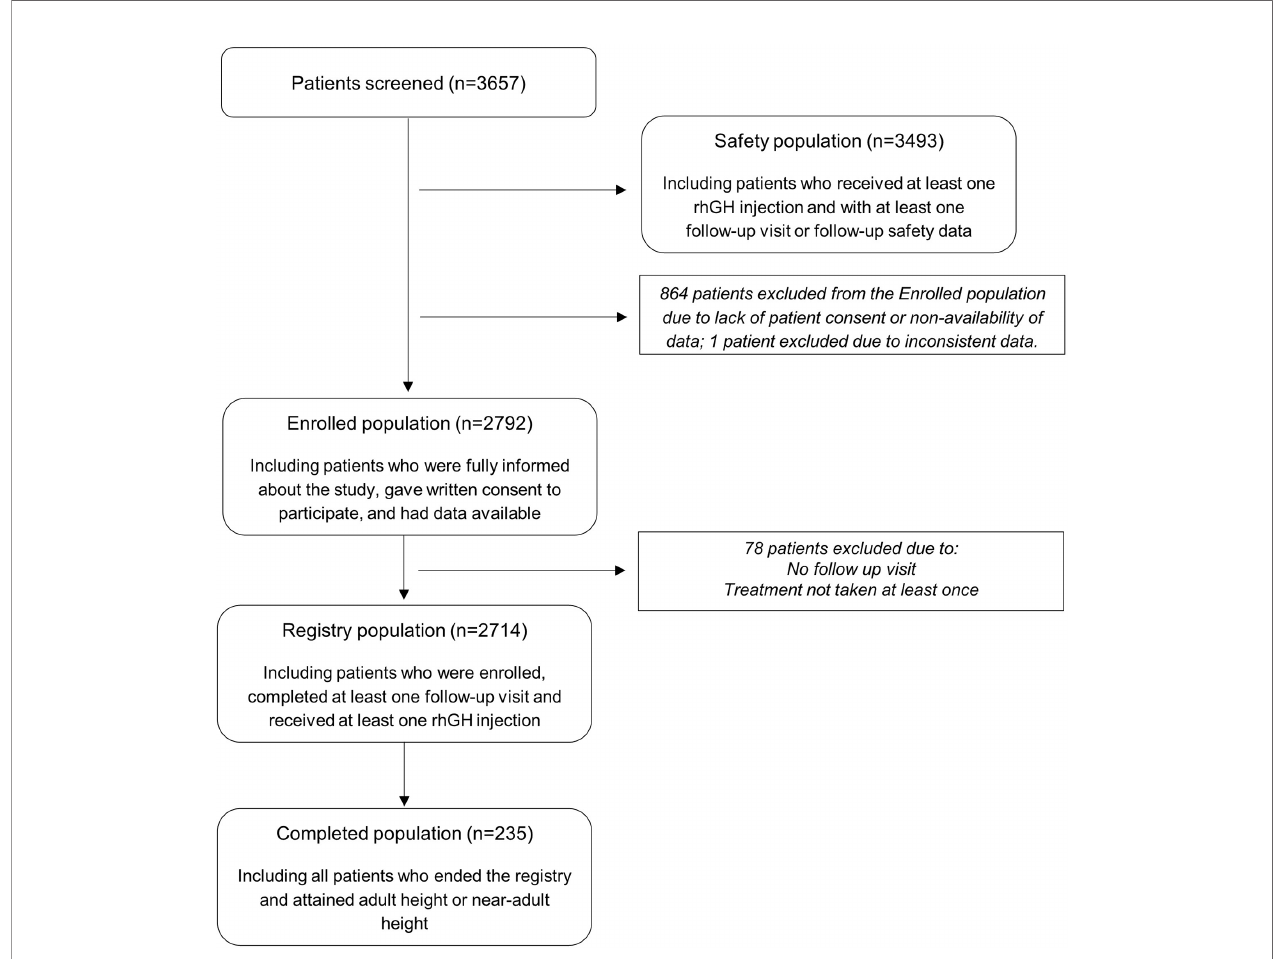
FIGURE 1 | International Cooperative Growth Study, NutropinAq ® European Registry participant fl ow